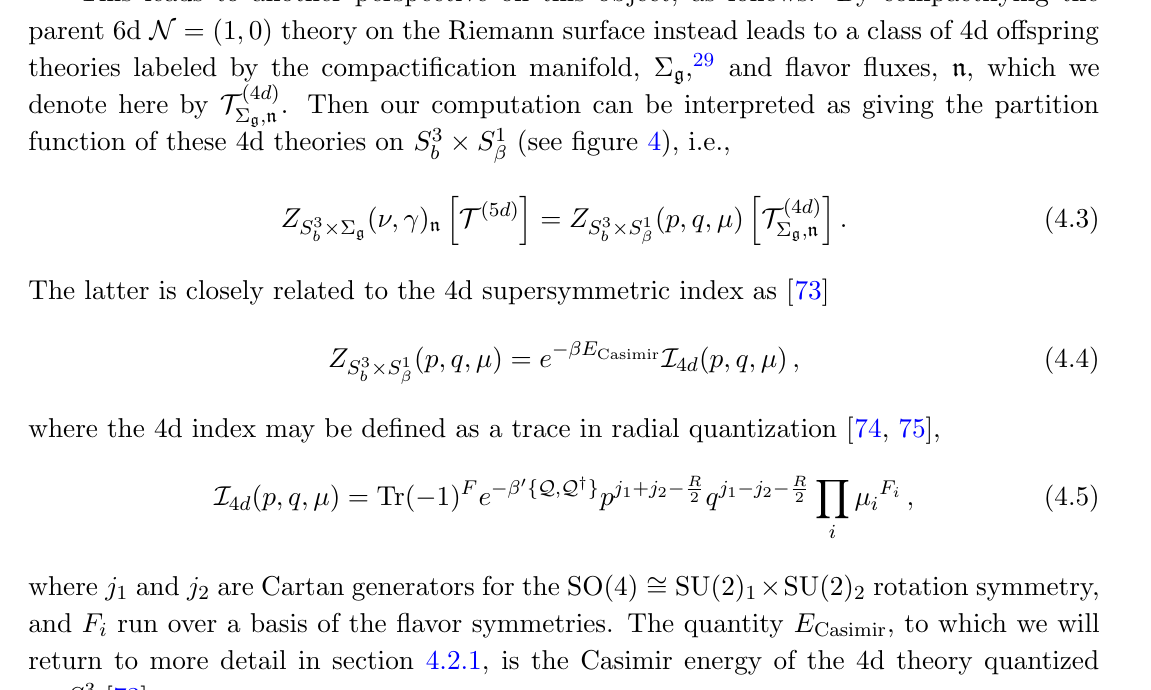
Figure 4 . The partition function of 4d N = 1 class S theories on S 3 function of N = 1 gauge theories on S 3 mapping of parameters in